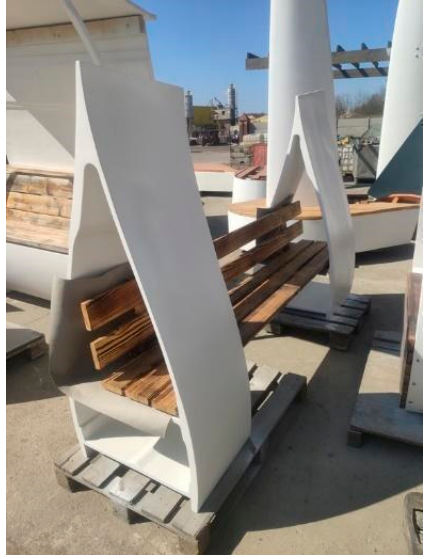
Figure A10. Blade-made sun loungers [49].